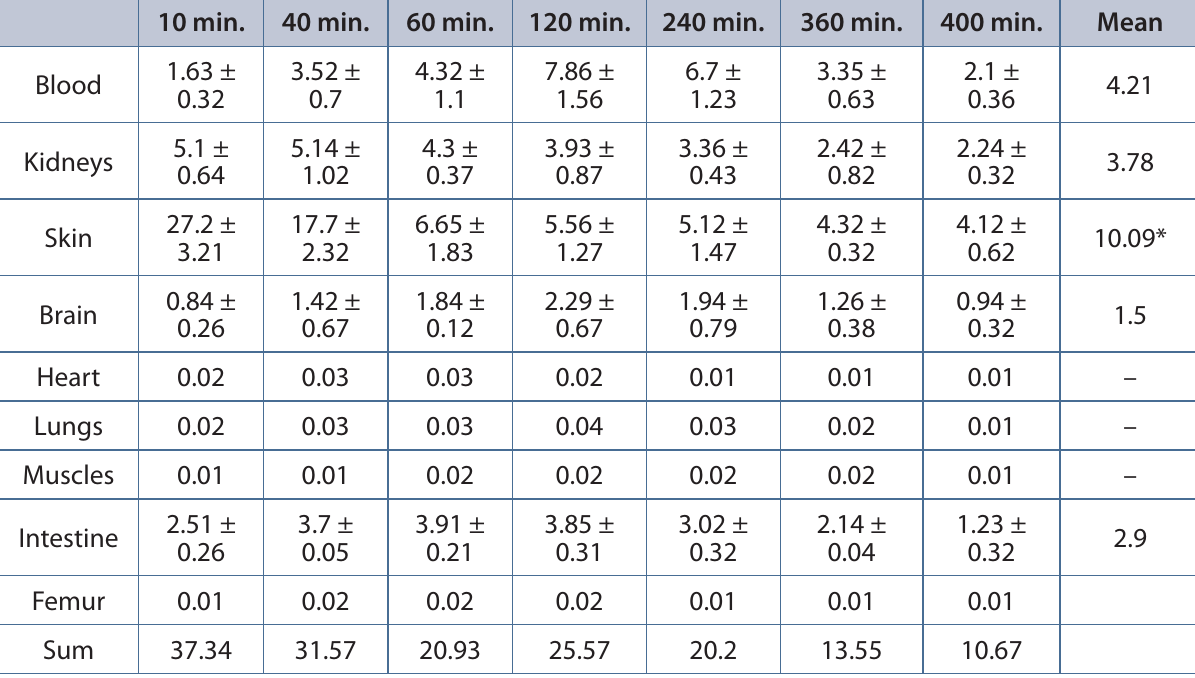
Table 1. Biodistribution of subcutaneously injected [ 125 I] H. lepturus venom in rat expressed as percentage of radioactivity/gram of the tissue (mean ± SD; n = 3) upon time (minutes). The times shown represent intervals following administration (10 µg 125 I-labeled venom per